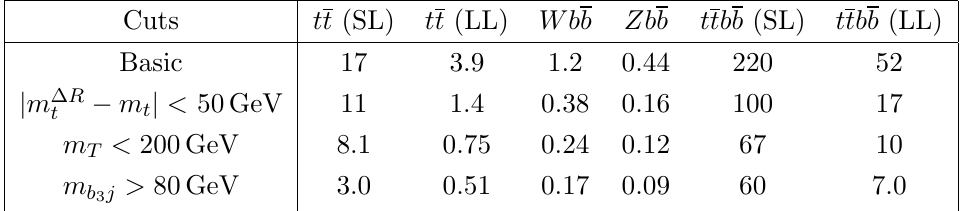
Table 3 . Cumulated e(cid:14)ciency 10 4 after each cut for the six dominant backgrounds. SL (LL) (cid:2) denotes semi (di)-leptonic decays.